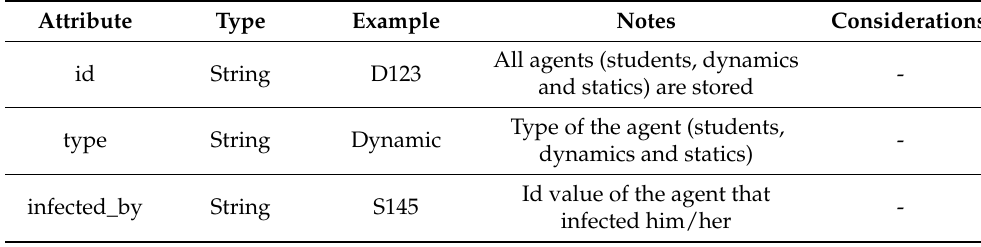
Table A9. Transmission_list.csv attribute table.